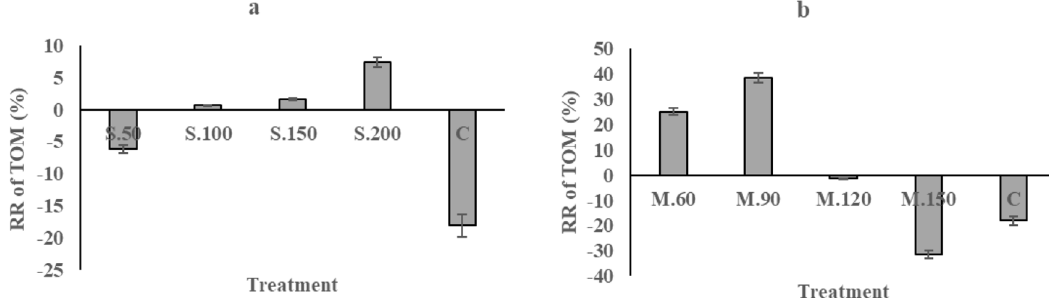
Fig. 3. The removal rates, averages and error bars of the four replications, of TOM (%) in the control and at four densities of G. verucosa (a) and P. viridis